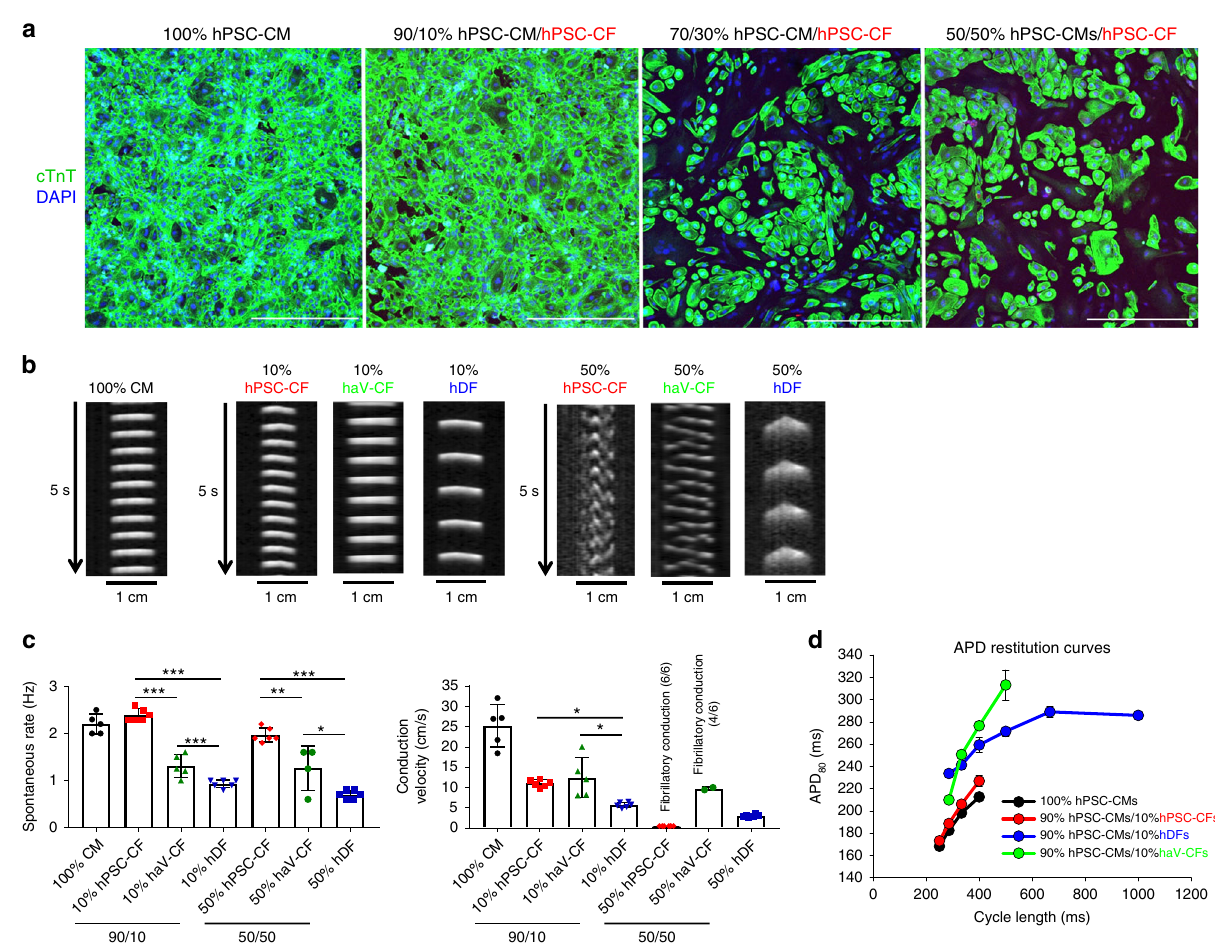
Fig. 10 Effect of CFs or DFs on hPSC-CM electrophysiology in co-culture. a confocal images of different ratios hPSC-CMs and hPSC-CFs in culture together with immunolabeling for cTnT to identify hPSC-CMs and DAPI labeling for all cells present. Scale bars are 500 µ m. b Time – space plots of optical mapping experiments. Postacquisition analysis of optical recordings was done by plotting the changes of fl uorescence over time along a single line of each monolayer, similar to a confocal line scan. Differences in the spontaneous rates of activation are evident as are altered patterns of conduction with fi brillatory conduction observed with 50% hPSC-CF and haV-CF co-cultures with hPSC-CM. c Average spontaneous beating rate and action potential propagation velocity for 100% hPSC-CM monolayers ( n = 5) compared to co-cultures of percentages and cell types indicated (red, hPSC-CF 10% ( n = 6) and 50% ( n = 4); green, haV-CF 10% ( n = 5) and 50% ( n = 6); blue, hDF 10% ( n = 6) and 50% ( n = 6)). Statistical comparisons were made between different fi broblast populations at each fi xed mixture with ANOVA and Tukey ’ s post hoc testing for signi fi cant differences as shown, *** P < 0.0001; ** P < 0.001; and * P < 0.01. d Average action potential duration at 80% of repolarization (APD80) restitution curves generated by pacing indicated preparations over a range of different cycle lengths and measuring optical APD80. The hPSC-CF and hPSC-CMs are derived from H9-cTnT-GFP hESCs. The haV-CFs are from Lonza, NHCF-V, and hDFs are from skin biopsy from a healthy adult donor. Data are mean ± SEM with n representing number of separate monolayers (biological replicates)